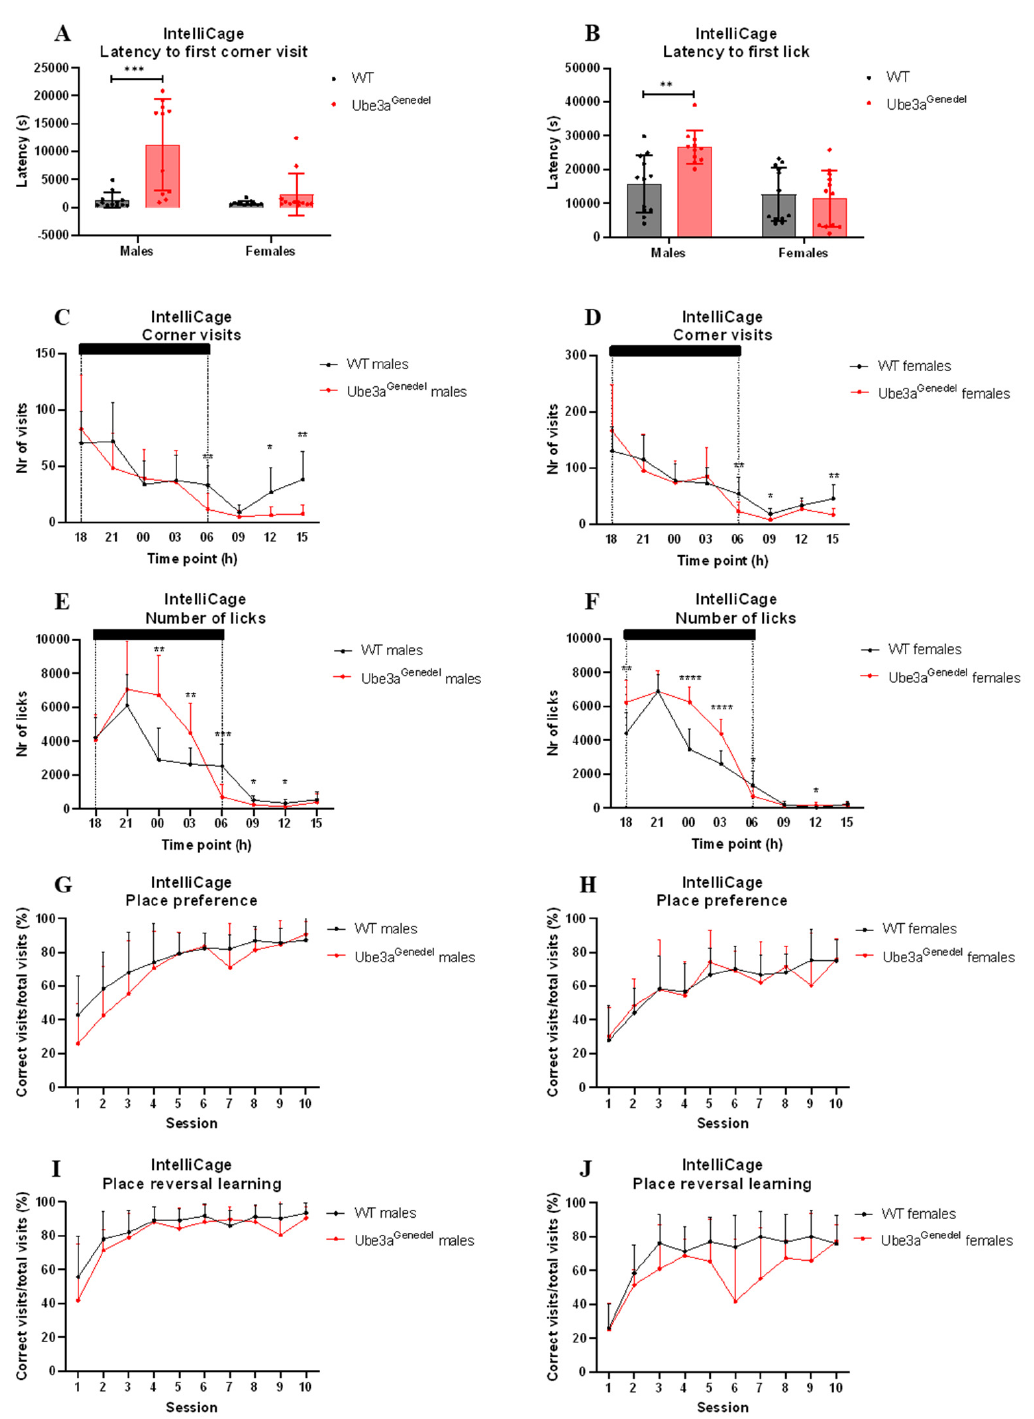
Figure 6. Results from IntelliCage measurements. ( A , B ) Ube3a genedel male mice exhibited increased latency to first corner visit and first lick over 7 days. ( C , D ) Ube3a genedel mice visited the corners less than WT littermates, which was pronounced during dark phases (shadowed). ( E , F ) Ube3a genedel mice exhibited an increase in lick number over the entire period. ( G , H ) Control and Ube3a genedel mice exhibited similar learning memory in place preference test. ( I , J ) Ube3a genedel mice exhibited less correct visits to rewarding corners than control animals during 10 sessions of reversal learning. Two-way ANOVA with dependent measurements, genotype main effect, p < 0.001, depicted with means ± SD. Significant effects of genotype are indicated as * p < 0.05, ** p < 0.01, *** p < 0.001, and **** p < 0.0001 for genotype significance.